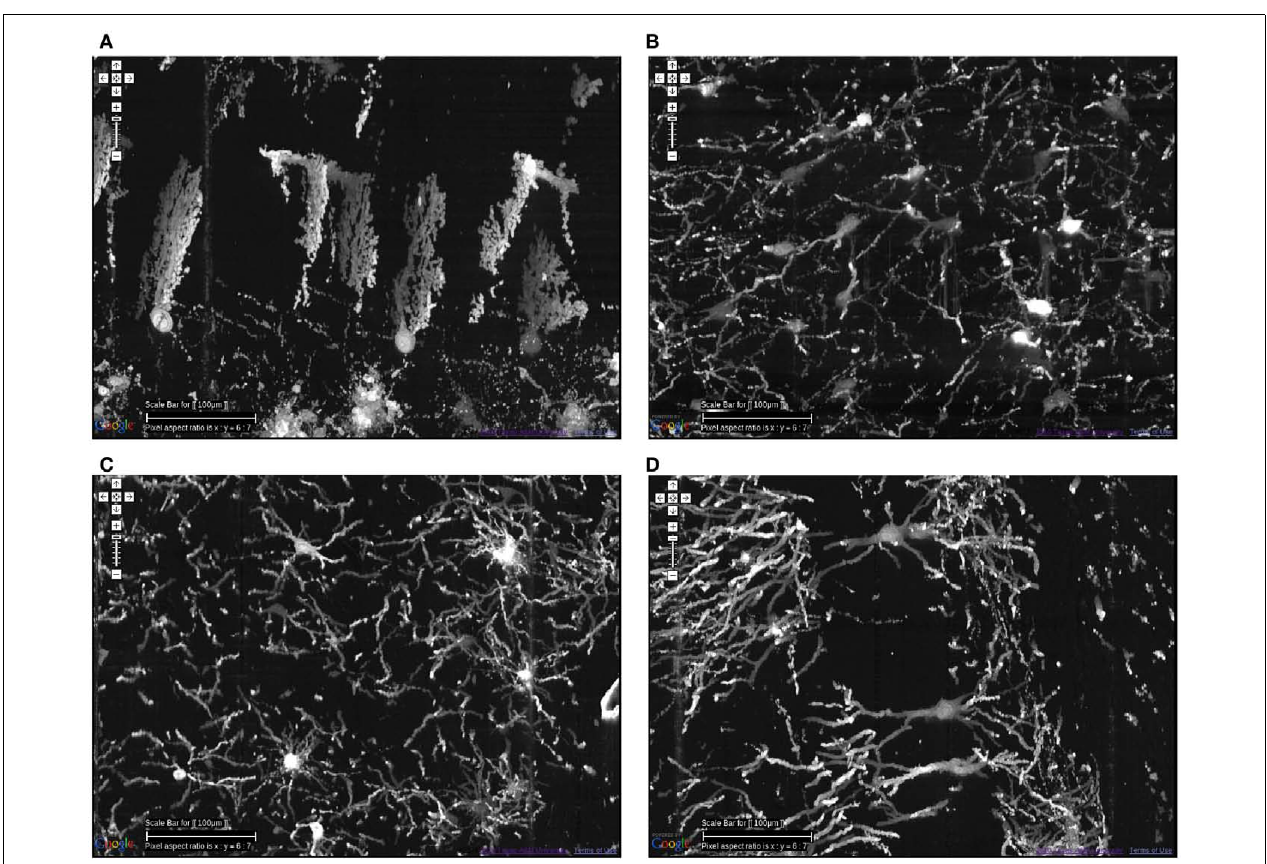
for circuits in the neocortex. Scale bar = 100 μ m. See Movie 2 in Supplementary Material (cerebellum, colliculi) and Movie 3 in Supplementary Material